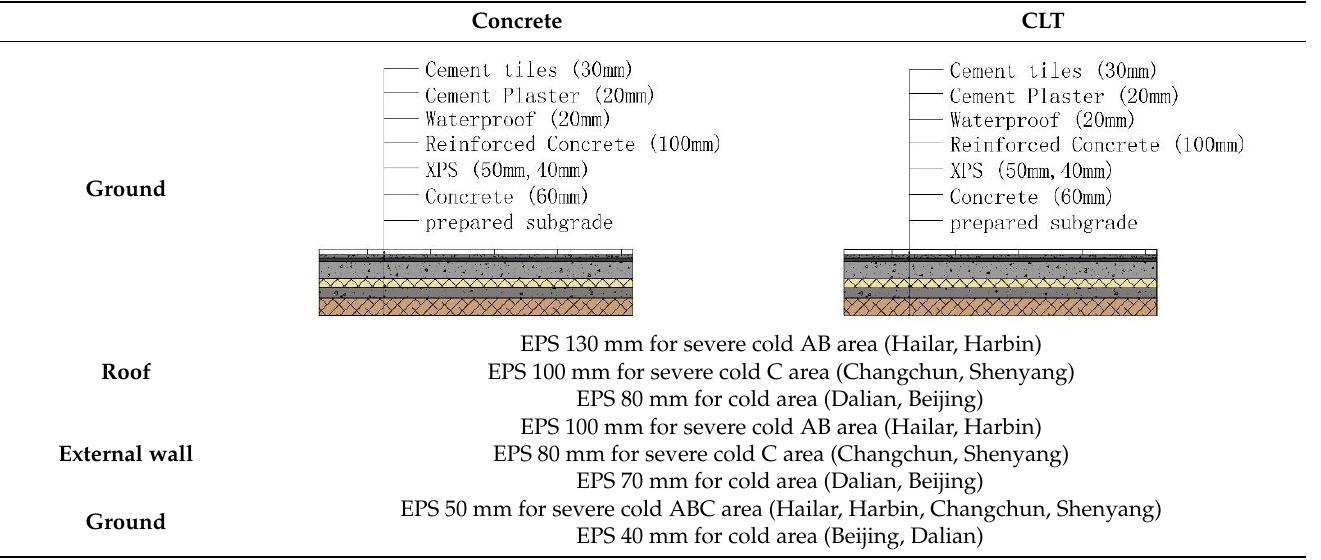
Table 5. Cont. Concrete